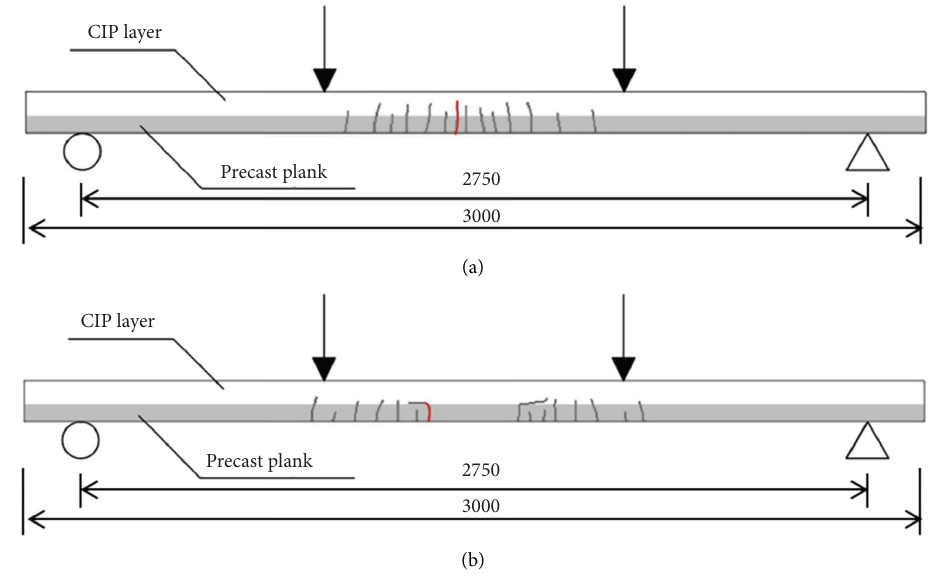
Figure 6: Crack patterns for specimens in the control group. (a) LGS01. (b)